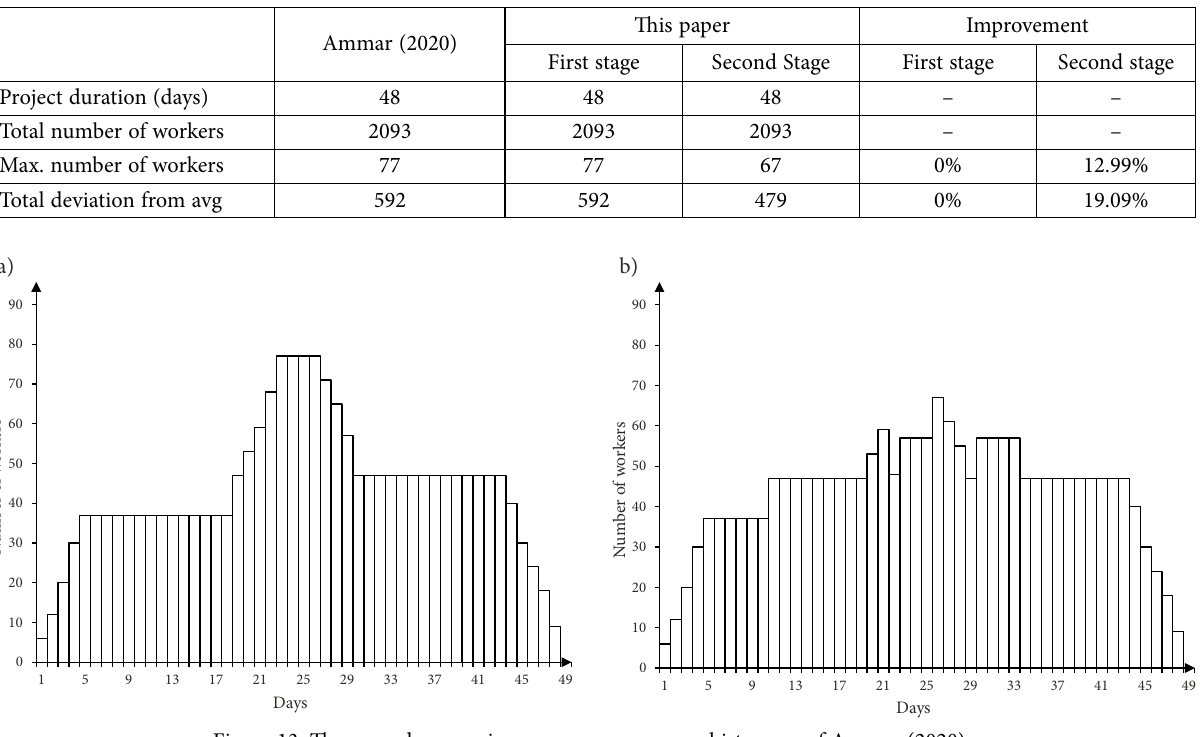
Figure 13. The second comparison: a – resource usage histogram of Ammar (2020); b – resource usage histogram of the proposed method